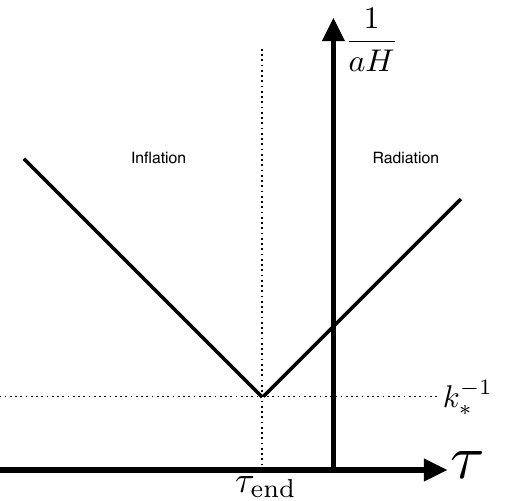
Figure 4 . Sketch of the evolution of the comoving Hubble horizon in the sudden transition